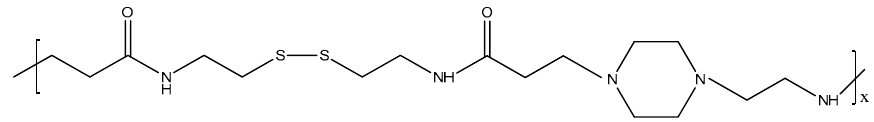
Figure 4. Chemical structure of poly(amido-amine) with disulfide linkage along the polymer